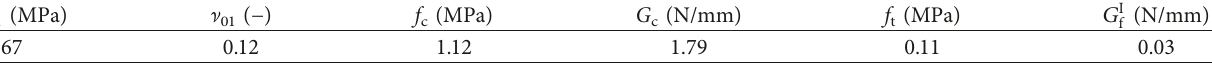
Table 5: Initial values for the mechanical parameters requested by the TSRCM.